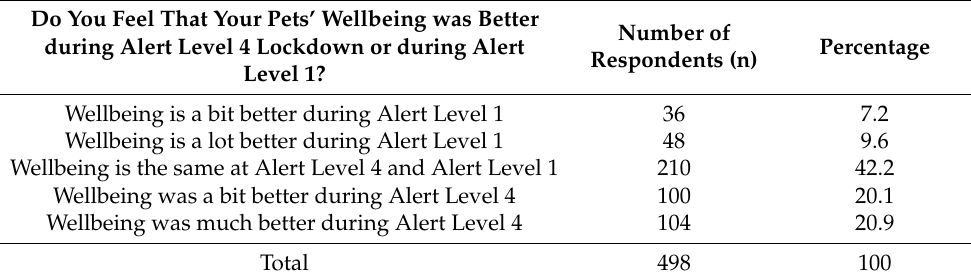
Table 6. Alert Level 4 and 1 comparison of pet wellbeing.